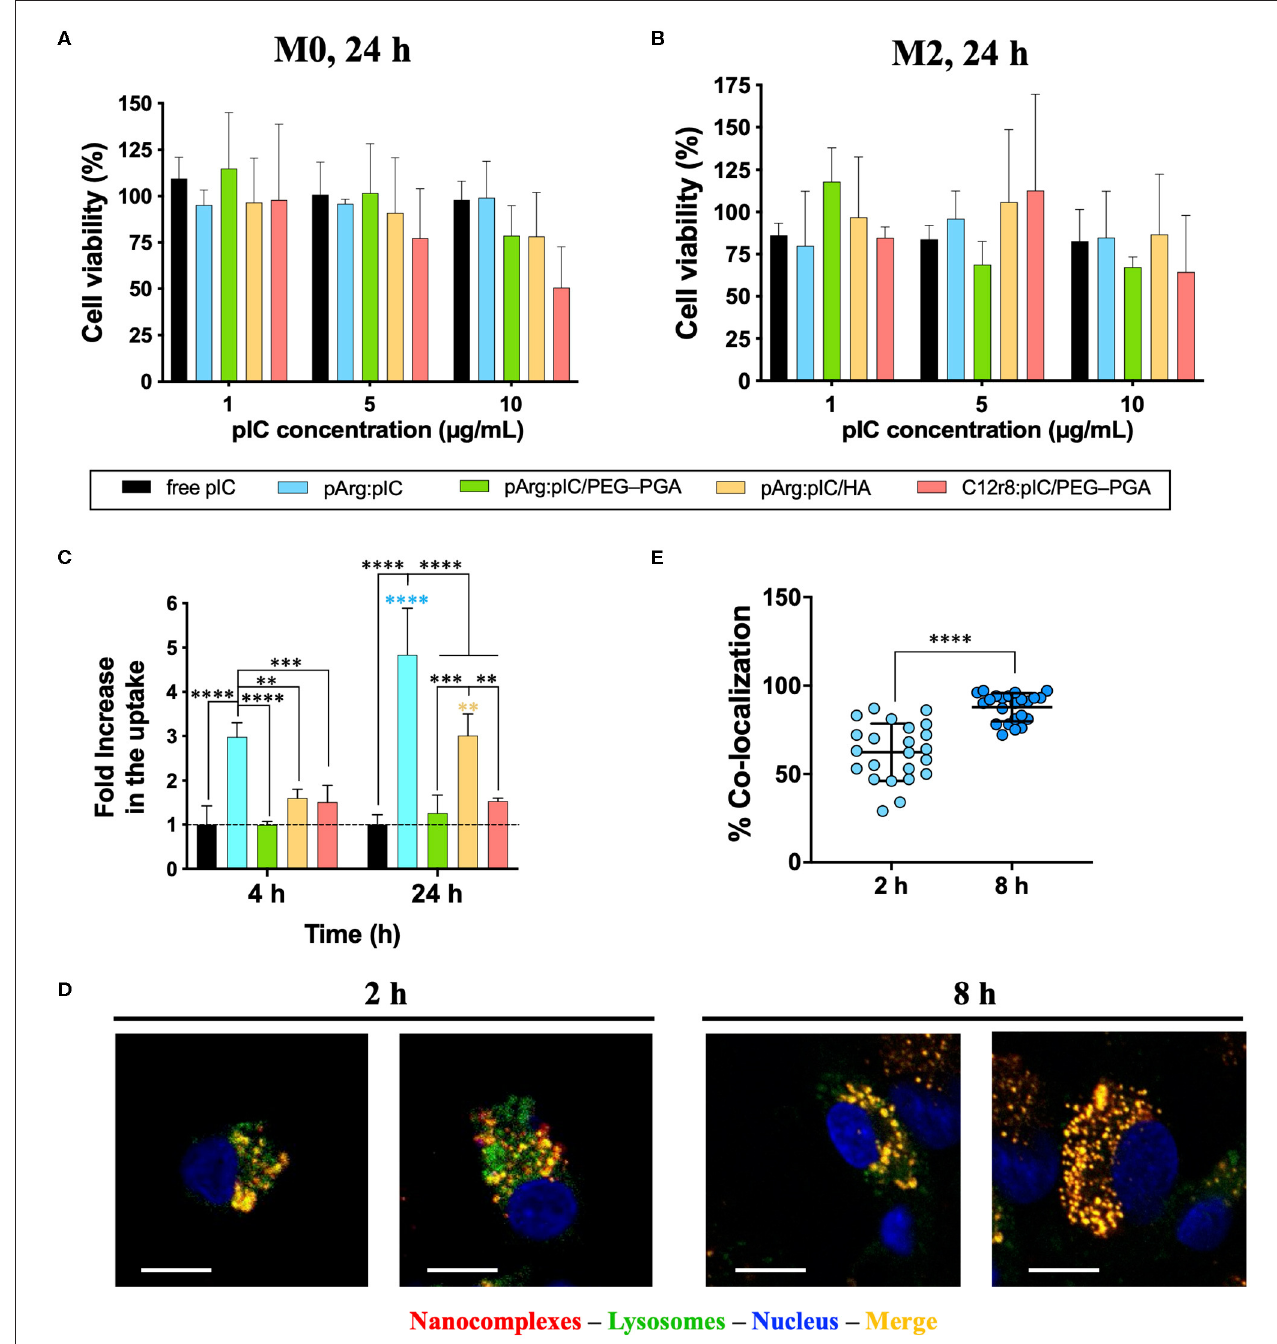
FIGURE 3 | Toxicity, uptake and cellular localization of poly(I:C) and nanocomplexes. Toxicity toward (A) M0 and (B) M2 primary human monocyte-derived macrophages after 24h of incubation. (C) FACS evaluation of rhodamine-labeled-poly(I:C) uptake by primary human monocyte-derived macrophages when included in the different nanocomplexes after 4 and 24h of incubation, expressed as the fold increase in comparison to free poly(I:C), for a final poly(I:C) dose of 5 µ g/mL. (D) Co-localization with the endosome of rhodamine-labeled pArg:pIC nanocomplexes after 2 and 8h of incubation (100x magnification, size bars of 10 µ m) evaluated by confocal microscopy. (E) Quantification of the co-localization of rhodamine-labeled pArg:pIC nanocomplexes with the endosome after 2 and 8h of incubation, with a poly(I:C) dose of 5 µ g/mL. Values represent mean ± SD ( n ≥ 3). Statistical comparison was done using a two-way ANOVA followed by a Tukey’s multiple comparison test. Statistically significant differences are represented as ** p < 0.01, *** p < 0.005, and **** p < 0.001. C12r8, laurate-octaarginine; HA, hyaluronic acid; pArg, poly-arginine; PEG–PGA, pegylated polyglutamic acid; pIC, poly(I:C).